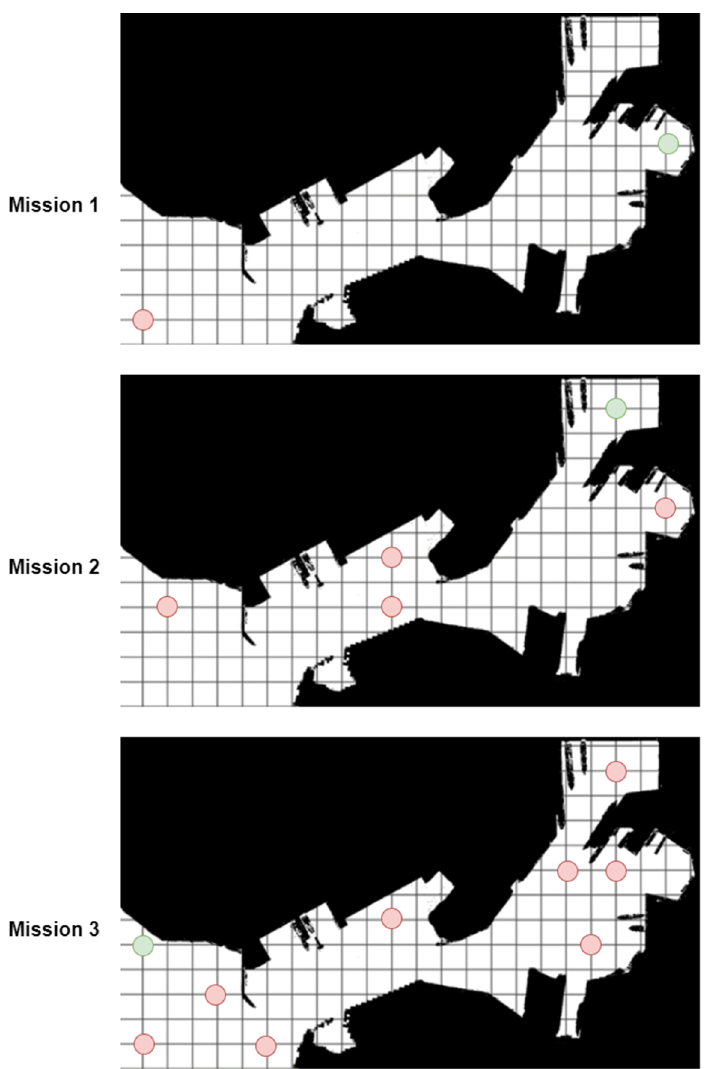
Figure 9. Missions used for the comparative evaluation. From top to bottom the Mission 1, Mission 2 and Mission 3 are illustrated, respectively.